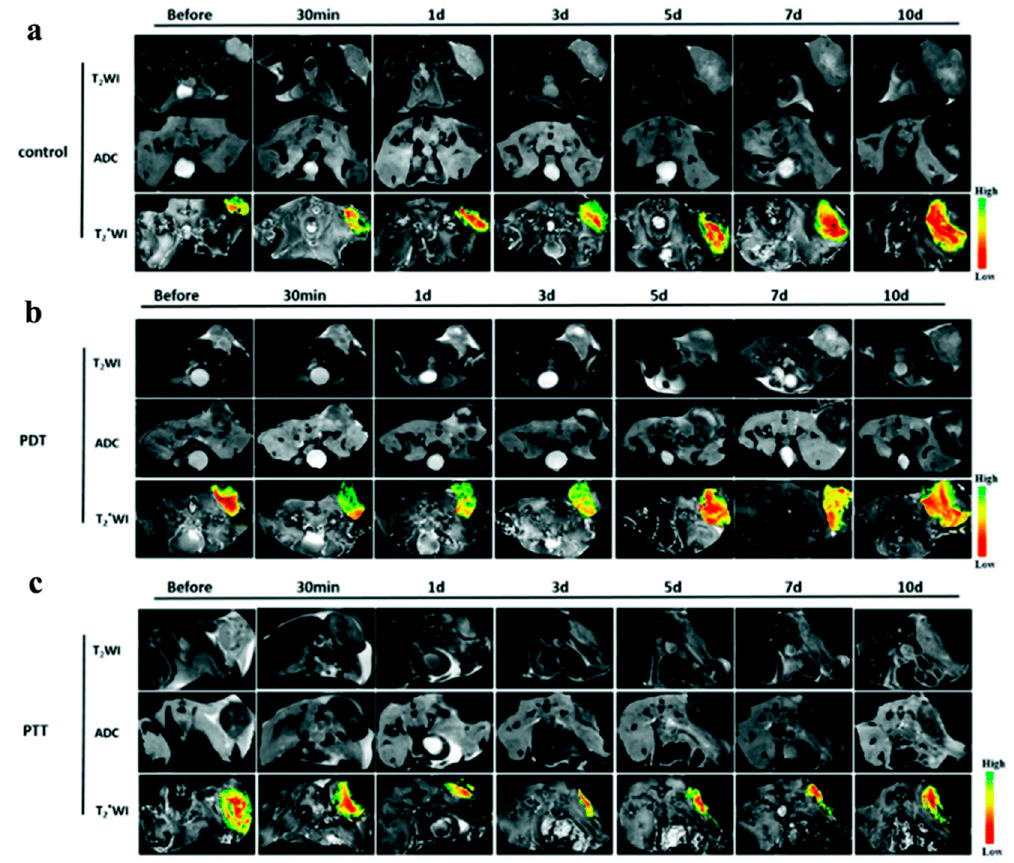
Figure 12. Cont . Figure 12.